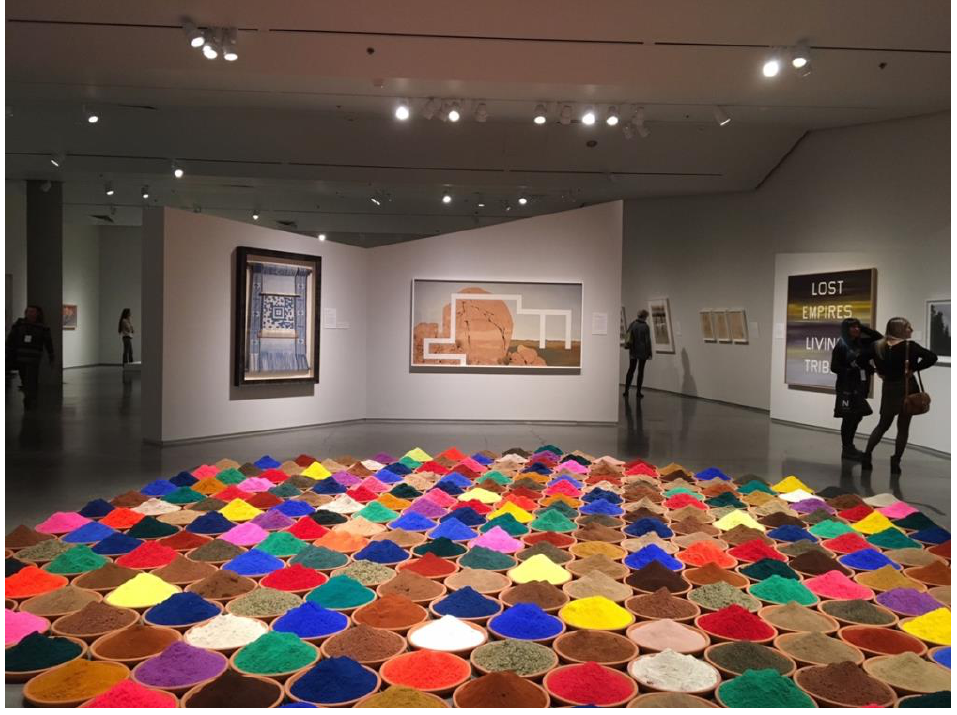
Lily Brewer, Gallery view of (L – R): Sonia Falcone Field of Color (2013), Guillermo Bert Mapuche Portal #1 (2014), Andrea Zittel Prototype For Billboard at A-Z West: Big Rock on Hill Behind House (2011), and Ed Ruscha Lost, Empires Living Tribes (1984), Nevada Museum of Art, 2018. All rights reserved.